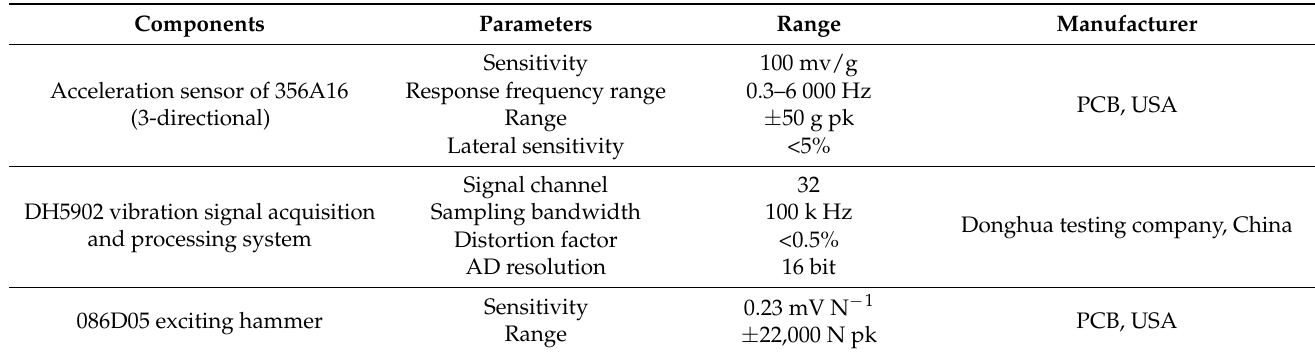
Table 1. Main parameters of vibration signal acquisition and processing